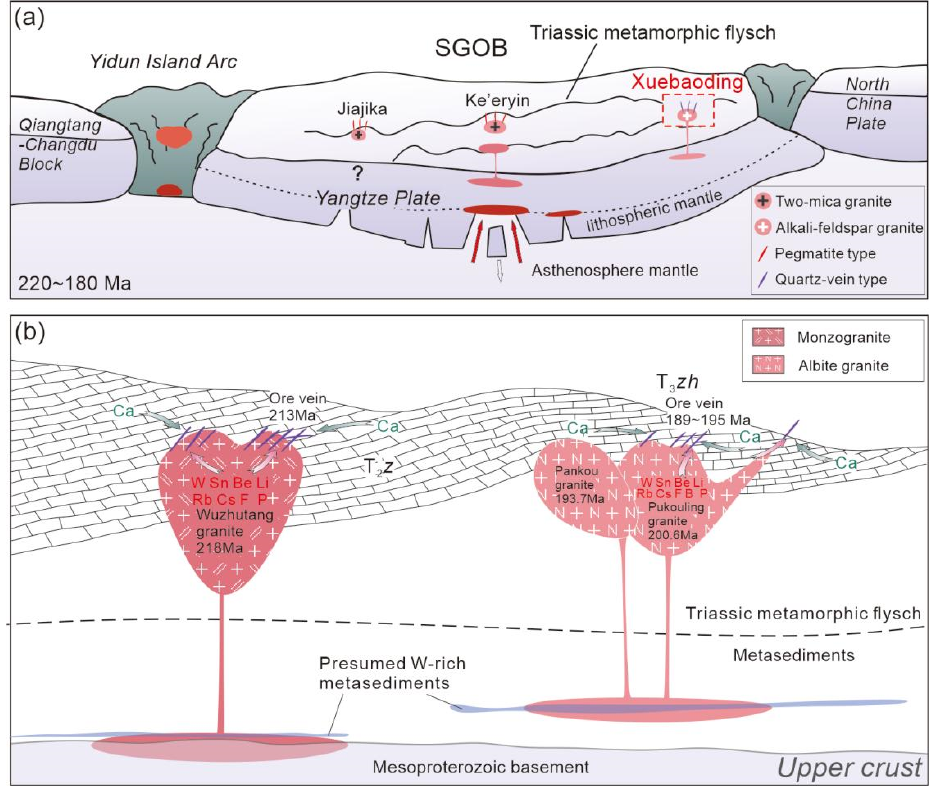
Figure 12. ( a ) Schematic model explaining the geodynamic setting of the rare metal mineralization in the Songpan–Garze orogenic belt (modified after [90]). ( b ) Schematic model illustrating the formation of granitoids and ore veins in the Xuebaoding mining area, Sichuan Province,